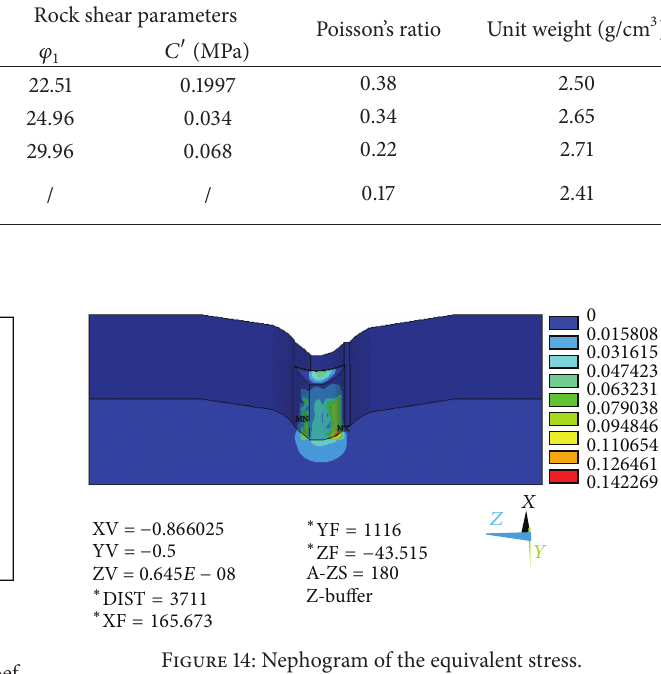
Figure 12: Relationship between the sediment and reduction coef- ficient on the node of QC10.